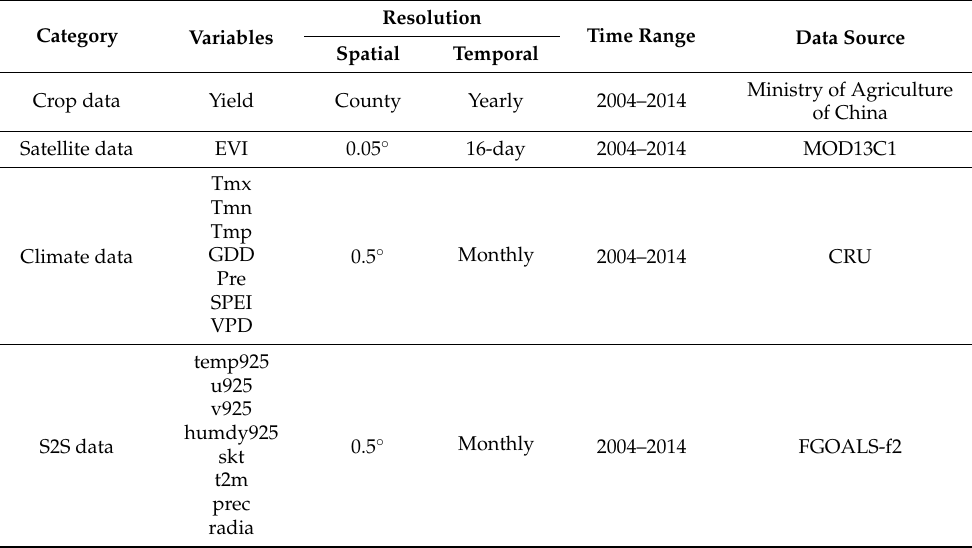
Table 2. Detailed information of the datasets used for winter wheat yield prediction in